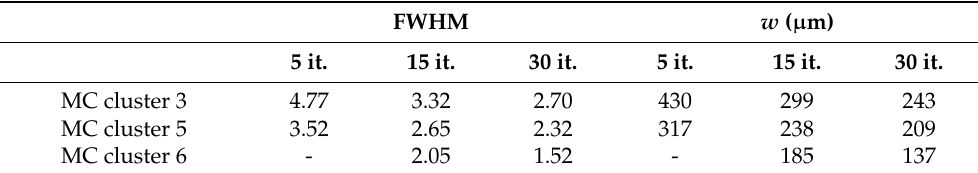
Table 3. Full-Width at Half Maximum (FWHM) index (26) and w measures (27) computed on the reconstructed MCs of the BR3D phantom, after 5, 15 and 30 SGP iterations. FWHM w ( µ